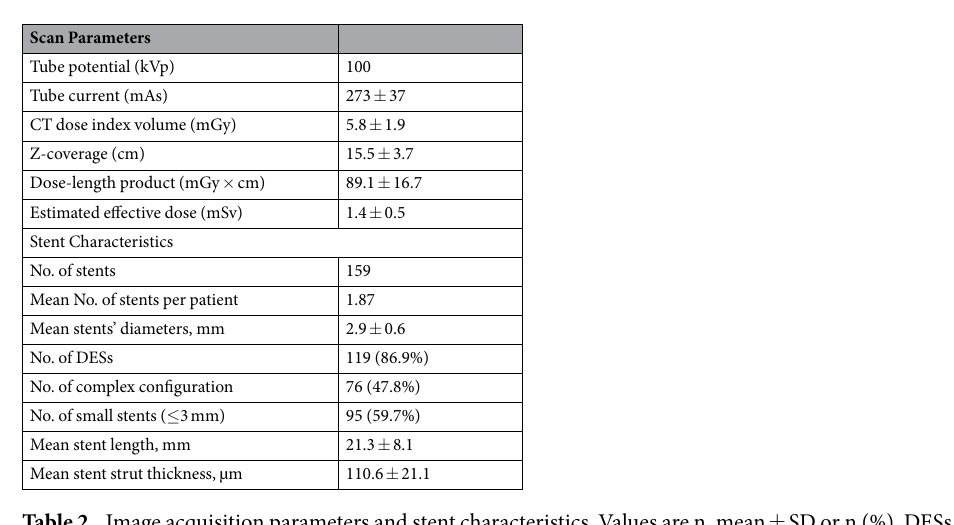
Table 2. Image acquisition parameters and stent characteristics. Values are n, mean ± SD or n (%). DESs equaled Drug-Eluting Stents. Complex configuration meant overlapping or bifurcation stenting